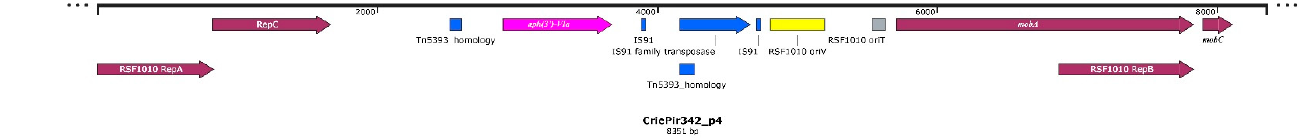
Figure 2. The structure of IncQ1 plasmid carrying amikacin resistance gene.